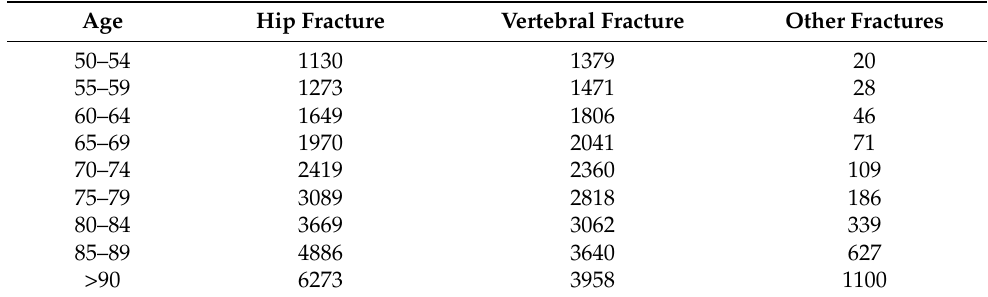
Table 4. Mortality rate per 100,000 inhabitants in the first year after fracture adjusted by comorbidities in Spain in 2010.